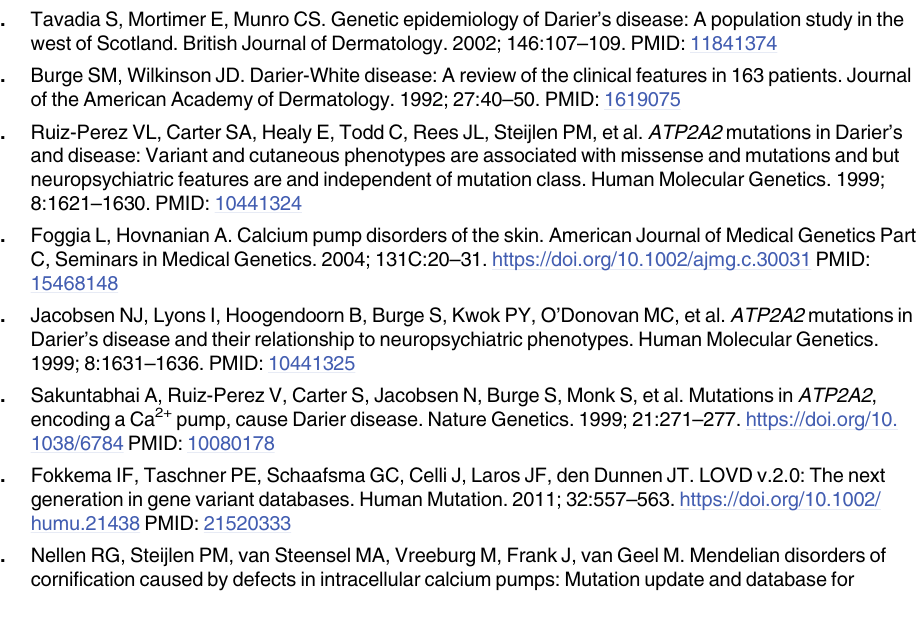
S2 Table. ASSP and Human Splicing Finder predictions for novel variants affecting splice sites found in this